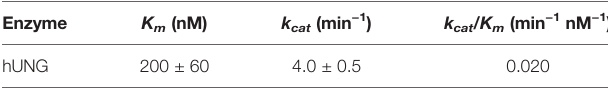
TABLE 1 | Kinetic parameters of the hUNG-catalyzed uracil-DNA incision activity.